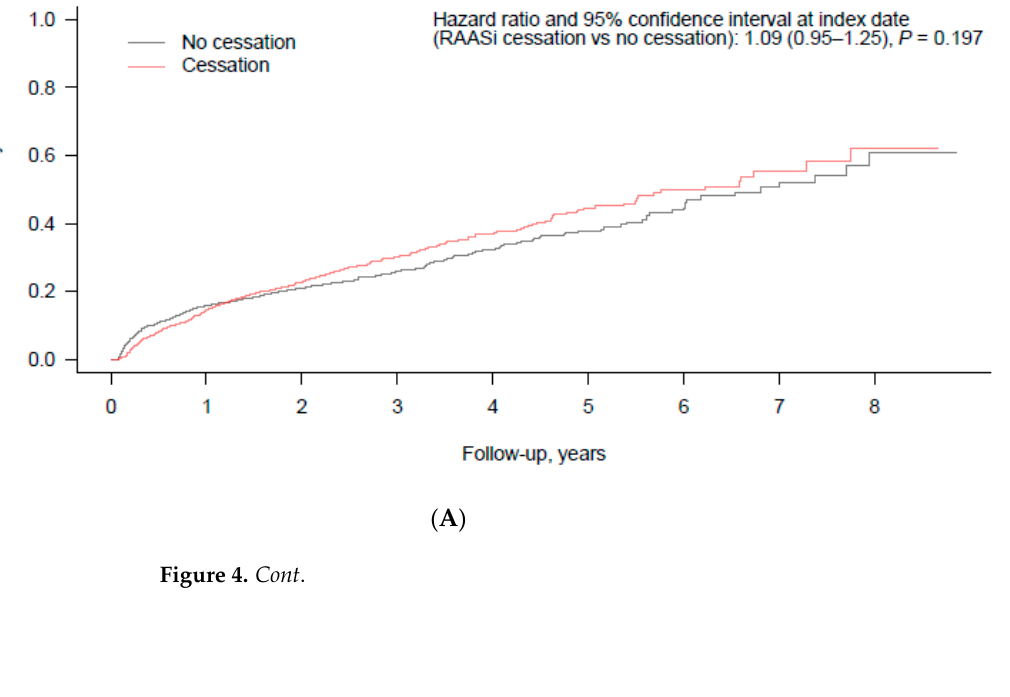
Figure 1. RAASi treatment according to dosage category (high, medium, or low) at the index date. Percentages were calculated using the total number of prescriptions. Abbreviations: ACEi, angiotensin-converting enzyme inhibitor; ARB, angiotensin receptor blocker; MRA, mineralocorticoid receptor antagonist; RAASi, renin–angiotensin–aldosterone system inhibitor.